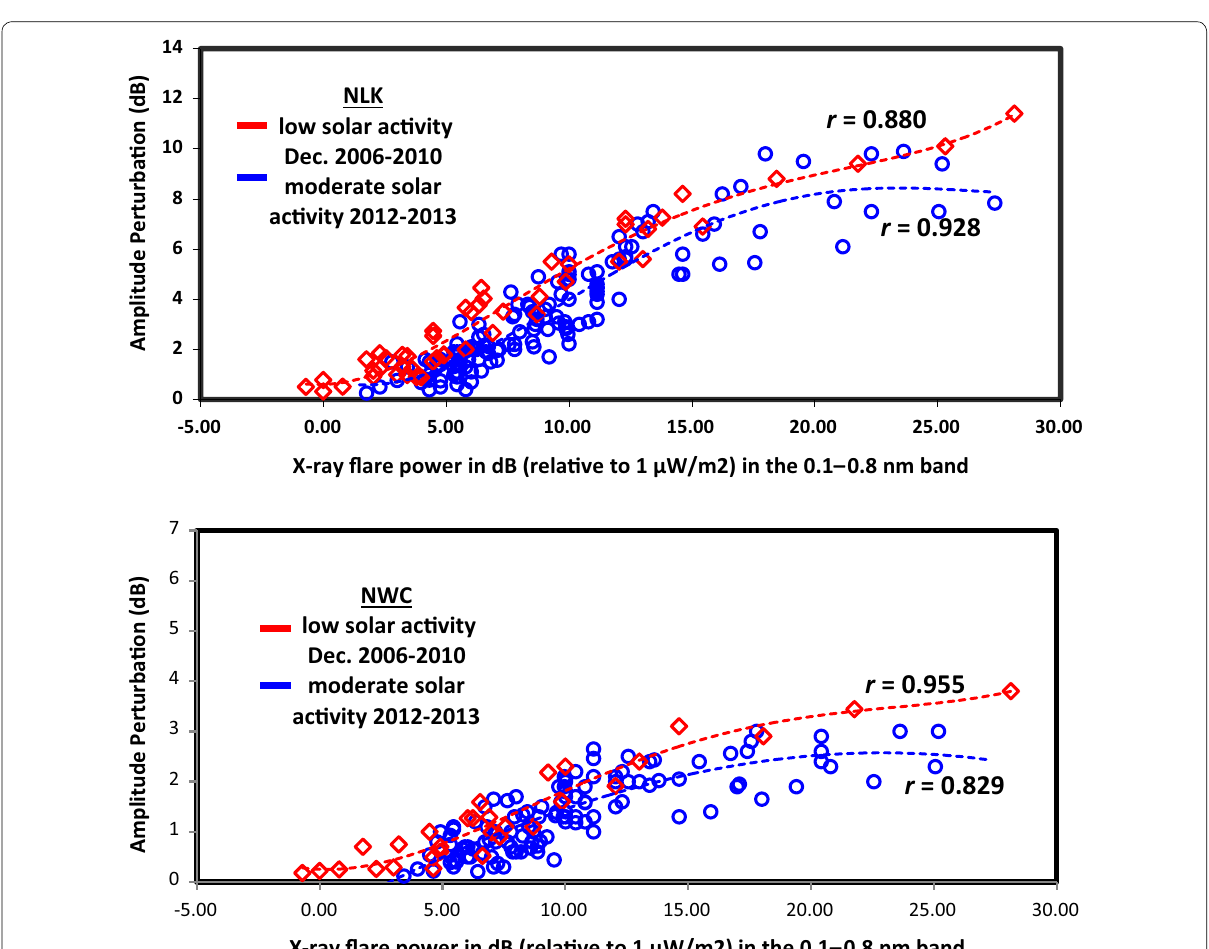
Fig. 4 VLF amplitude perturbations for NLK and NWC measured at Suva, Fiji, as function of solar flare X-ray flux measured in dB relative to 1 µW/m 2 in the 0.1–0.8 nm band, for low-solar activity conditions (red points and corresponding red best-fit curve) and moderate-solar activity conditions (blue points and corresponding blue best-fit